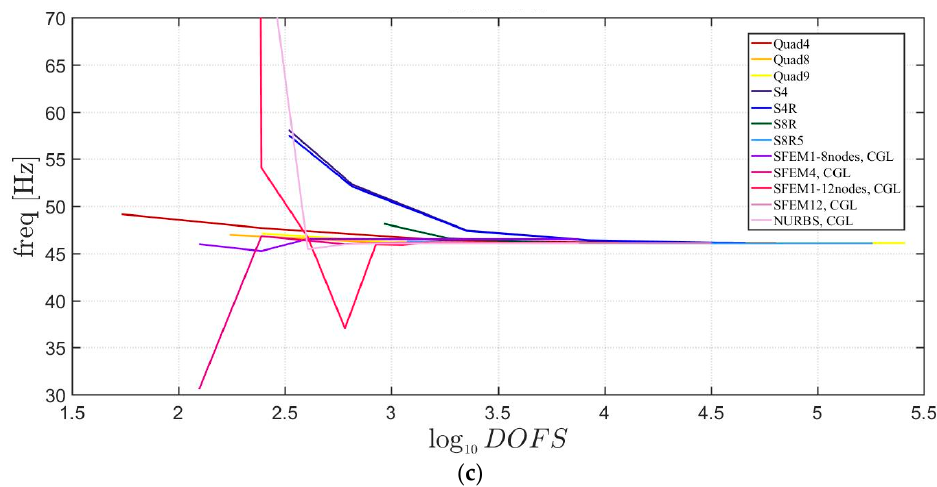
Figure 7. First three natural frequencies of an isotropic elliptic plate with b / a = 1.5: ( a ) First frequency; ( b ) Second frequency; ( c ) Third frequency.